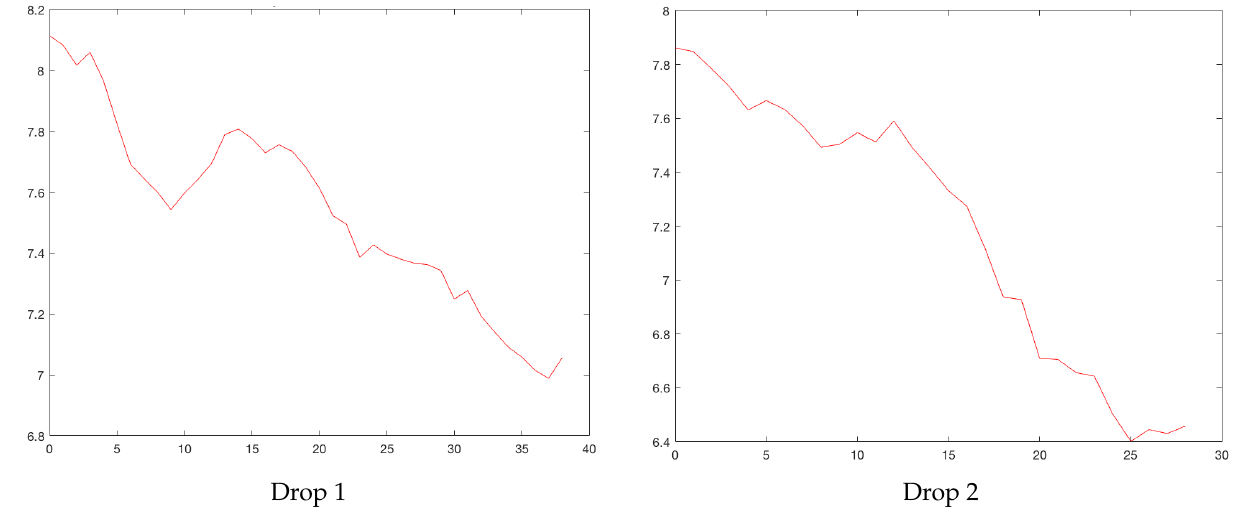
Figure A6. Lima’s drops. Horizontal axis, days; vertical axis: logarithm of daily